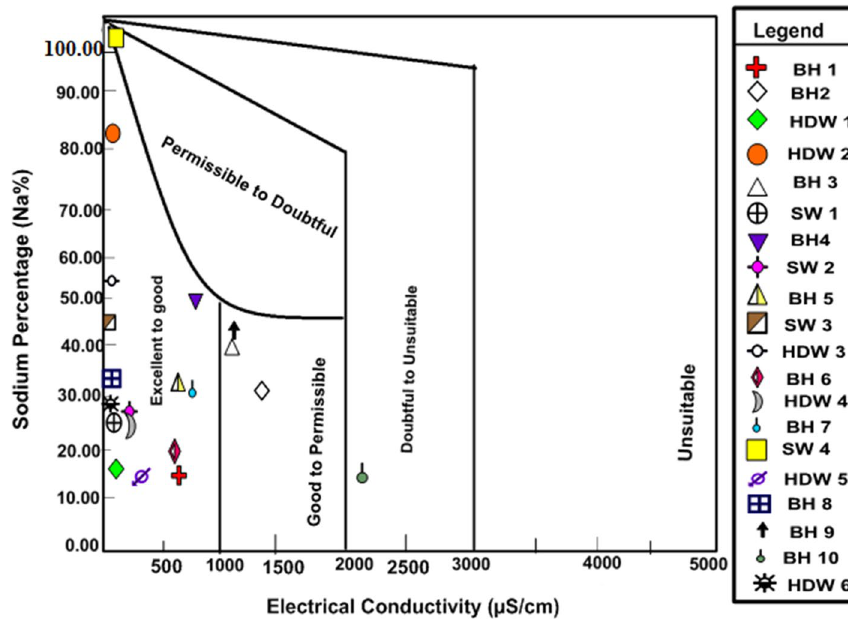
Fig. 11 Graphical correlation of electrical conductivity and sodium